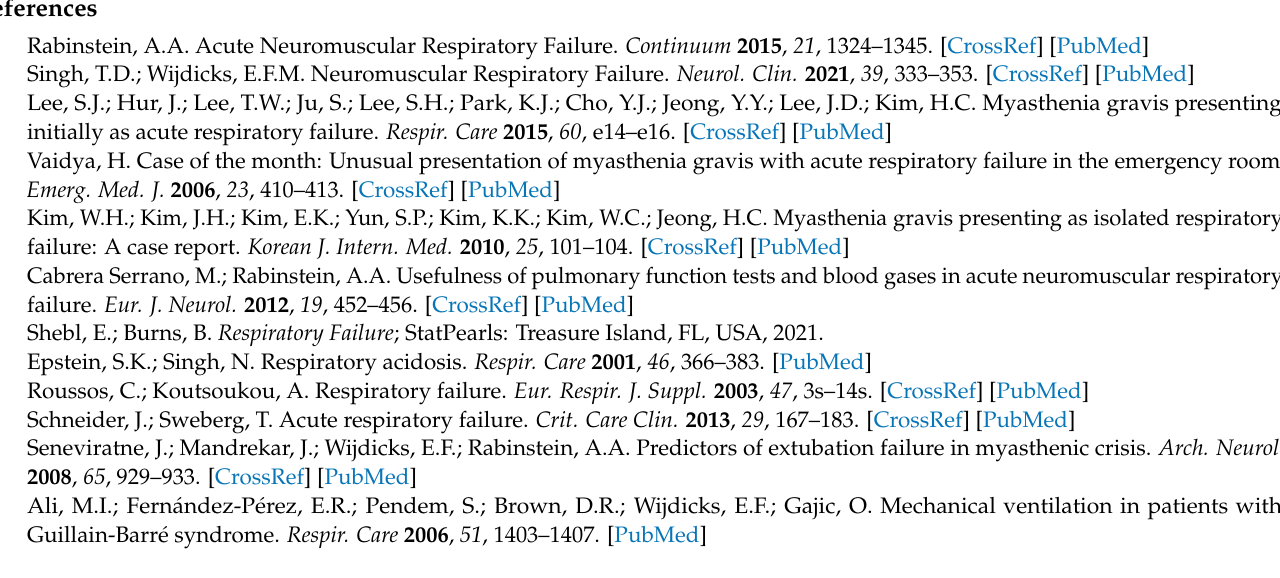
Figure S1. Scatter plot for ABG parameters data for NMRF and non-NMRF